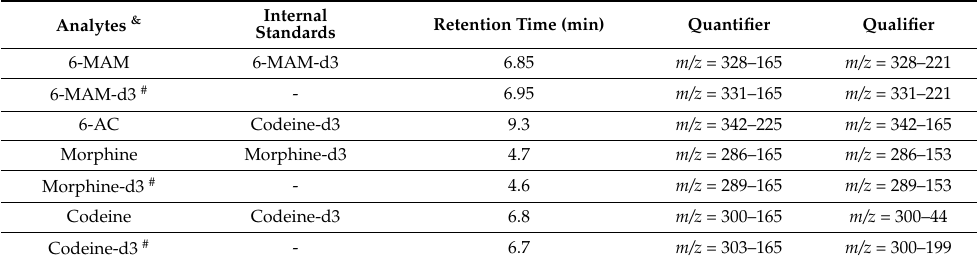
Table 1. LC-MS/MS data for heroin biomarkers, morphine, and